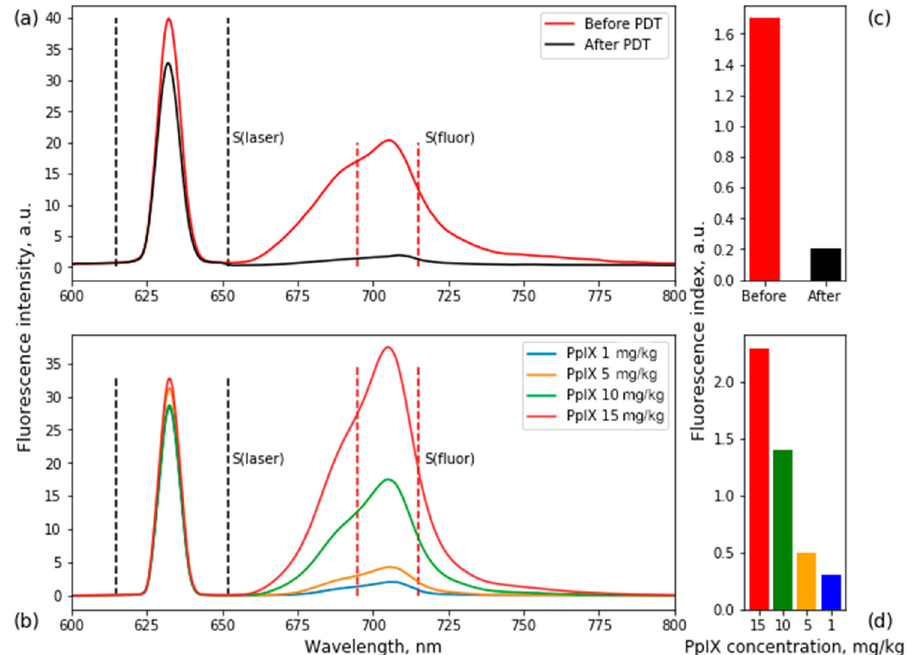
Figure 3. Fluorescence emission spectra of PpIX accumulated in tumor tissue before and after PDT ( a ), fluorescence spectra of optical phantoms with PpIX ( b ). Histograms of PpIX fluorescence index in tissues ( c ) and phantoms ( d ). Fluorescence index = S(fluor)/S(laser). Correlating fluorescence indices, PpIX concentrations before and after PDT were 12 and 0.7 mg/kg, respectively.